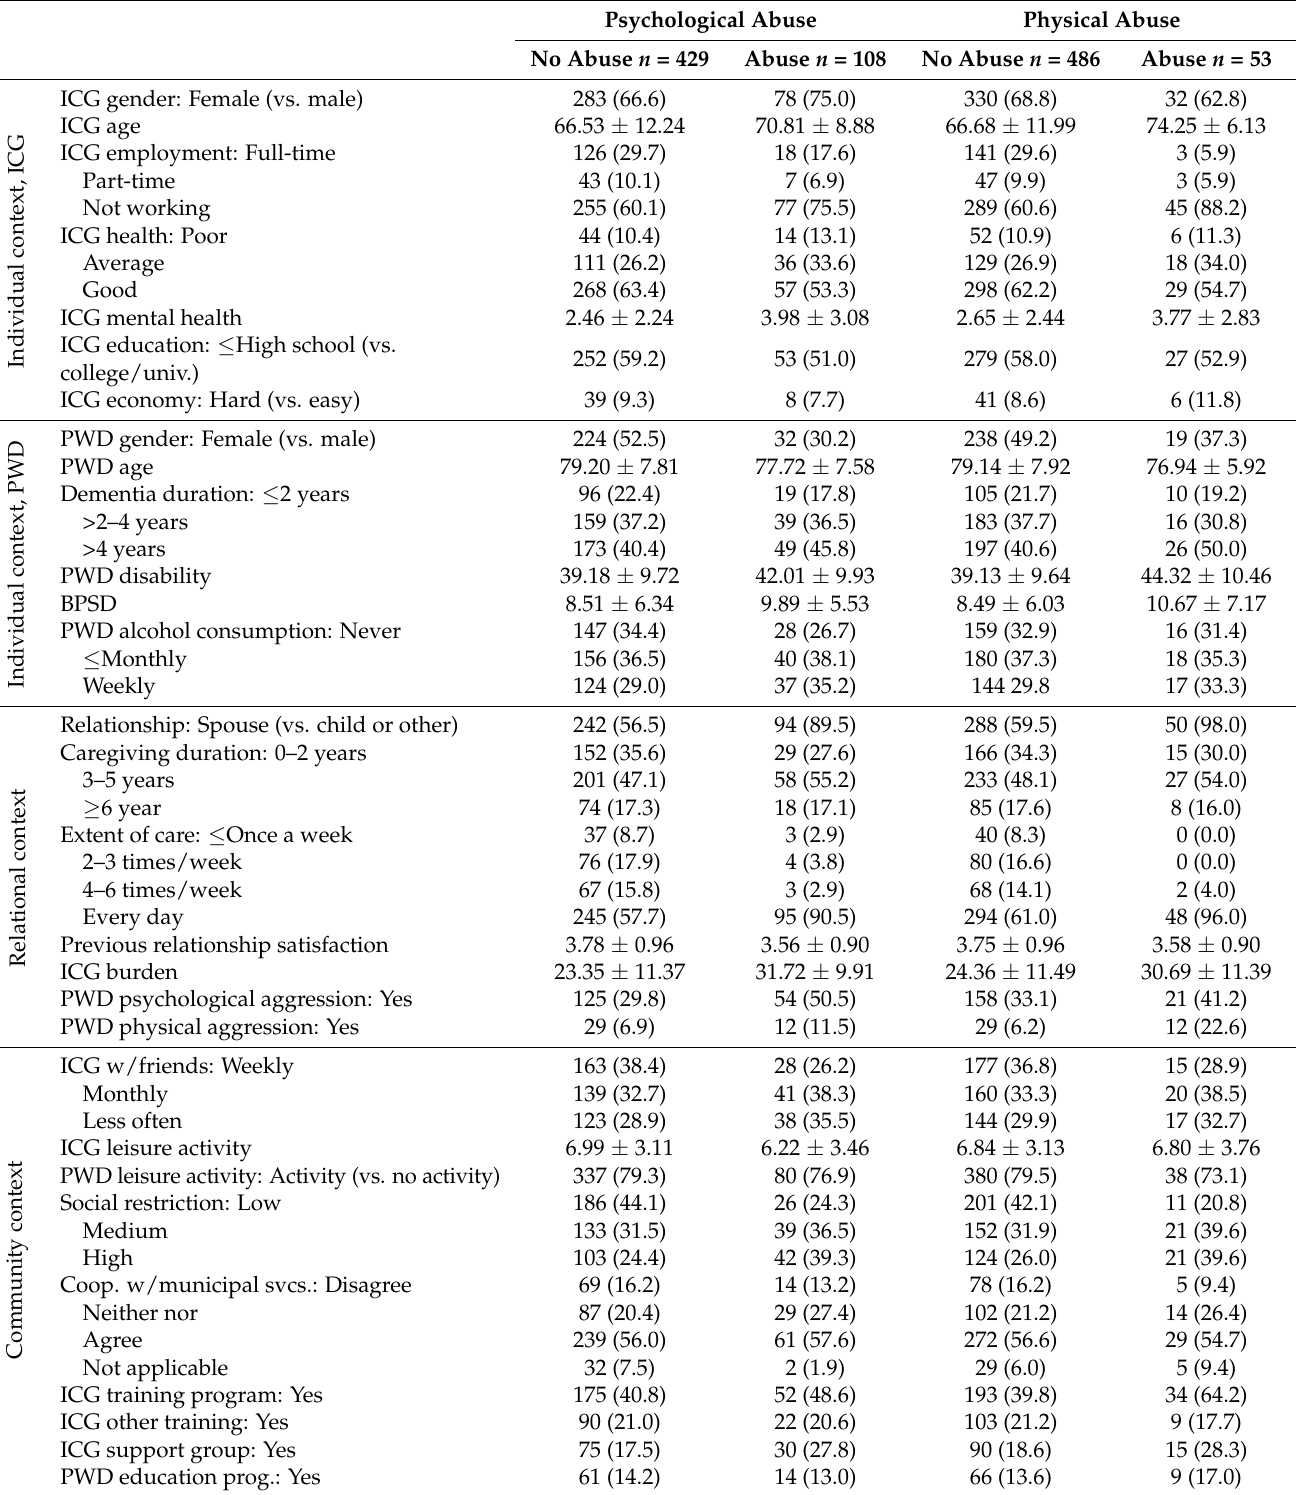
Table 2. Descriptive statistics for covariates according to elder abuse subtype in frequency (%) or mean ±